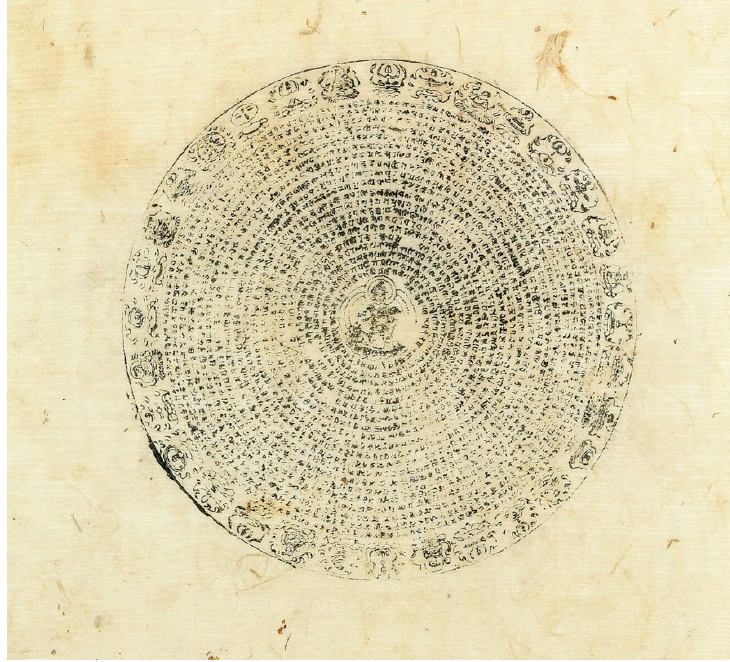
Figure 3. Pratisara Dharani (K. Sugu darani), Goryeo (12th century), woodblock print, 32.3 × 34.8 cm, enshrined in the statue Wooden Seated Avalokitesvara of Bogwangsa Temple. Source: (Research Institute of Buddhist Cultural Heritage 2009, p. 52).